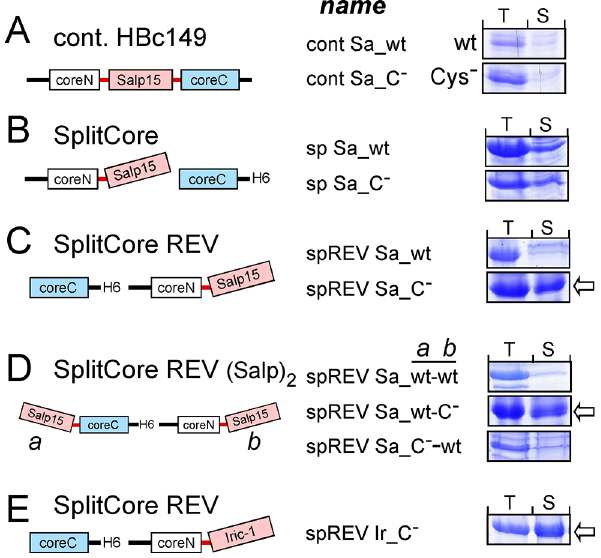
Fig 5. Screening for soluble Salp15 HBc fusions. Cells from induced cultures of BL21 * CP cells transformed with the indicated tick protein — HBc fusion constructs were lysed under non-denaturing conditions. Unfractionated total lysate (T) and soluble supernatant (S) after centrifugation were compared by SDS-PAGE. For all SplitCore constructs, the gel section with the tick protein containing large core segment is shown. wt, Wild-type protein; C - , Cys-free variant. (A) Contiguous chain HBc149 with c/e1 inserted Salp15. The complete gel lanes are shown inS3A Fig. (B) SplitCore with Salp15 fused to coreN. (C) SplitCore constructs with coreN and coreC ORFs in reverse order (SplitCore REV). Failure of alternative expression strains to promote higher solubility of the wt-Salp15 fusion is shown in S3B Fig. (D) SplitCore REV constructs bearing Salp15 on both coreN and coreC. (E) SplitCore REV construct bearing Cys-free Iric-1 on coreN. The complete gel lanes are shown in S3C Fig. Note the strong positive impact on solubility of replacing the endogenous tick protein cysteines in the SplitCore REV but not the contiguous chain HBc constructs.